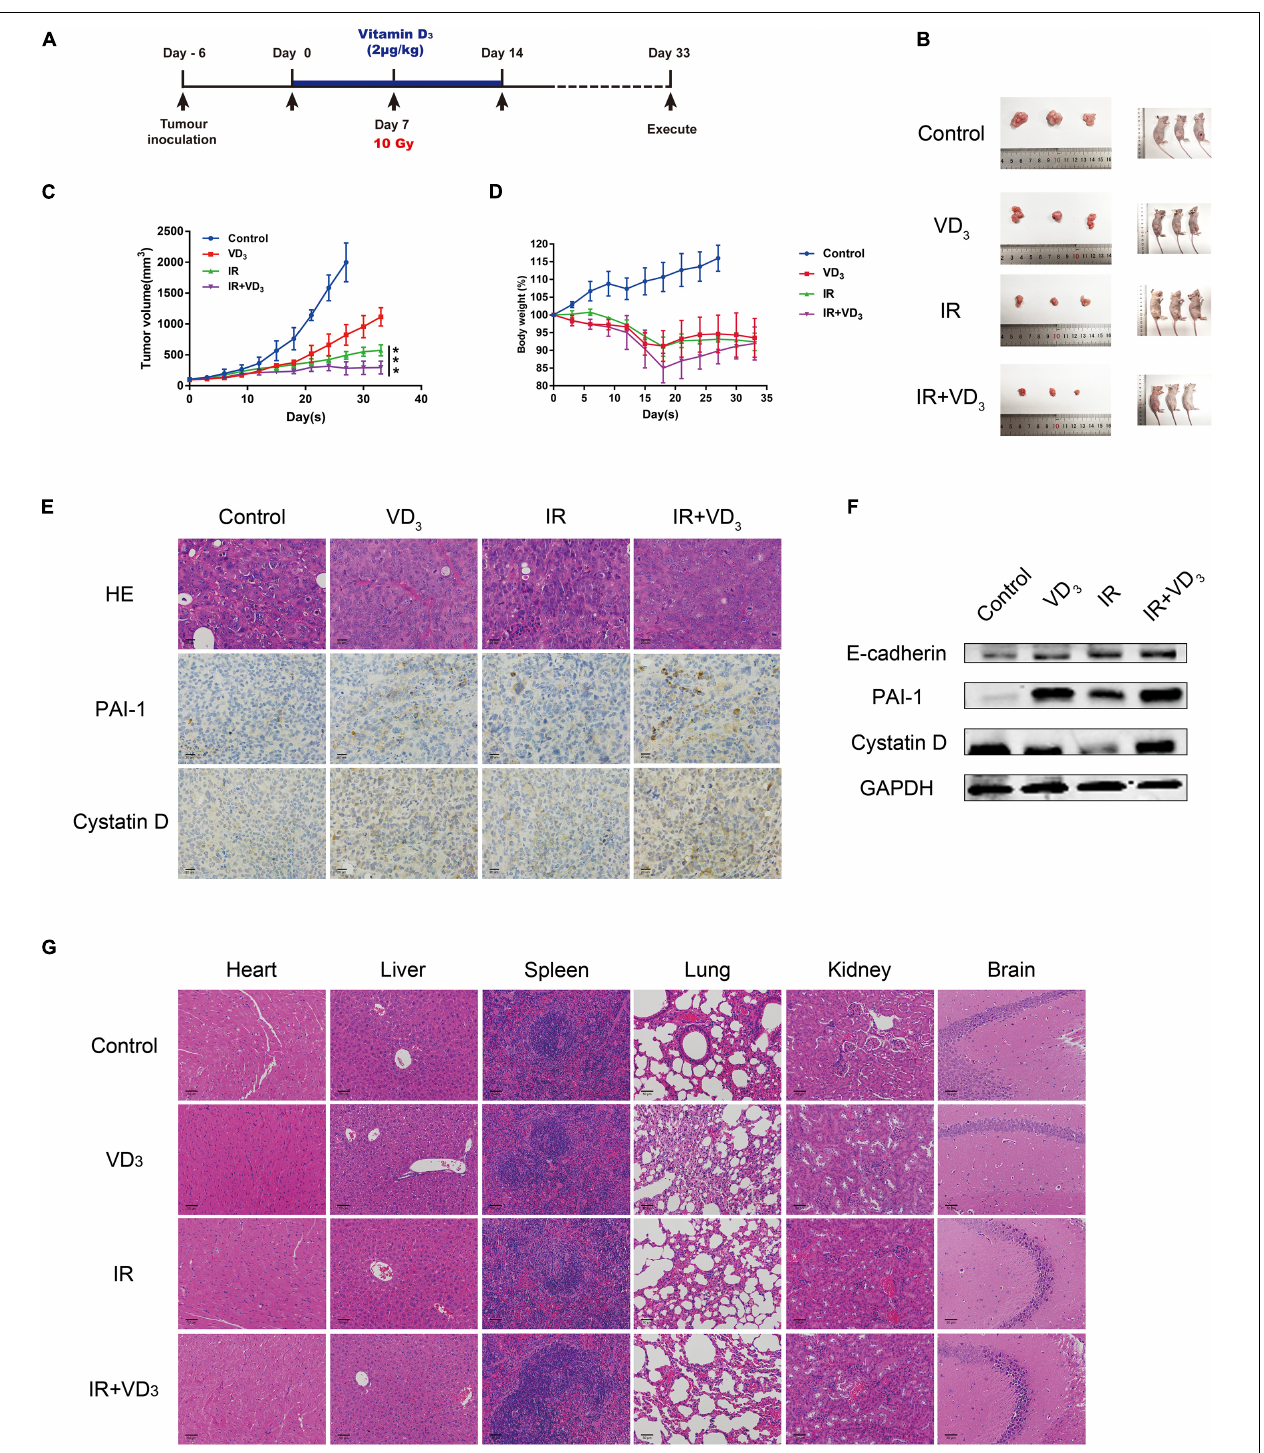
FIGURE 6 | VD 3 enhanced sensitivity to IR in vivo without additional toxicity. (A) Experimental design was shown. Day -7: SW480 cells (1 × 10 7 ) were subcutaneously inoculated into the right hind limb of nude mice; Day 0: Tumors were pretreated with VD 3 (2 µ g/kg, intraperitoneal injection); Day 7: Tumors were irradiated once with 10Gy. Tumor size was measured every other day. (B) Images of the dissected tumors. Tumors in the control group were harvested on day 28, and rest groups were harvested on day 33. (C,D) Growth curves for xenograft tumors and body weight of nude mice. (E) IHC of cystatin D and PAI-1 and H&E staining in xenograft tumors. Scale bar: 20 µ m. (F) Protein levels of cystatin D and PAI-1 in tumors were tested by western blot. (G) Images of H&E staining for organs from the mice. Scale bar: 50 µ m. ***p < 0.001.